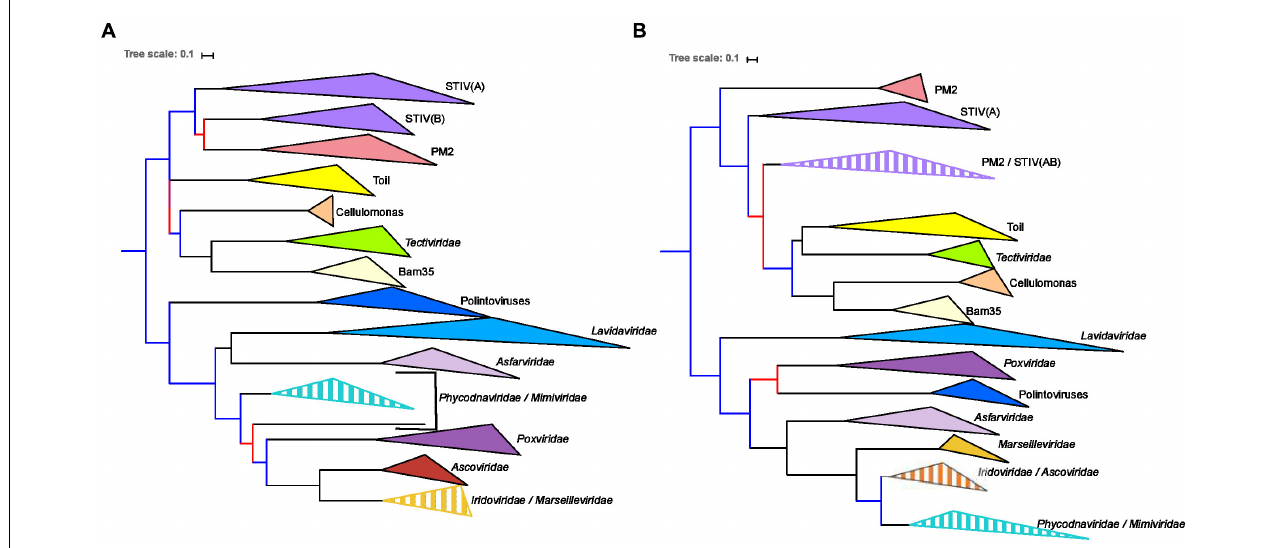
FIGURE 1 | Single-protein trees of the two hallmark proteins of the viruses from the Varidnaviria realm, excluding Adenoviridae, Sphaerolipoviridae . Phylogenetic trees of (A) the major capsid protein (MCP) and (B) packaging ATPase (pATPase). The root of the phylogenetic tree was between the prokaryotic and eukaryotic members. The scale-bar indicates the average number of substitutions per site. The best-fit model for the MCP tree was LG + F + R4, which was chosen according to Bayesian Information Criterion (BIC) and the alignment has 103 sequences with 237 positions. The best-fit model for the pATPase tree was LG + R6, which was chosen according to BIC and the alignment has 103 sequences with 171 positions. More detailed versions of the trees are shown in Supplementary Figures 4 , 5 . Branches in black indicate both classical bootstrap and transfer bootstrap expectation (TBE) support values using 1,000 replicates are above 70%. Branches in blue indicate only one of the two support values is above 70% whereas branches in red indicate both support values are below